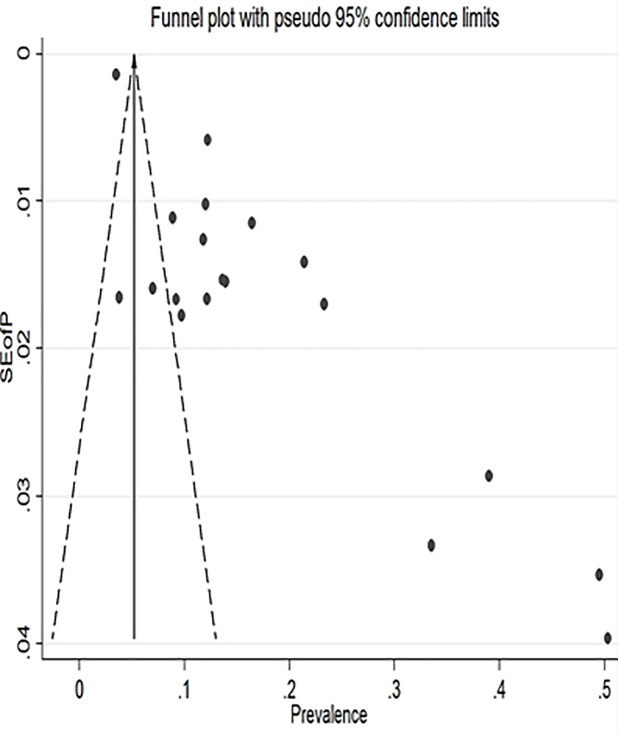
Funnel plot with pseudo 95% confidence interval limits.